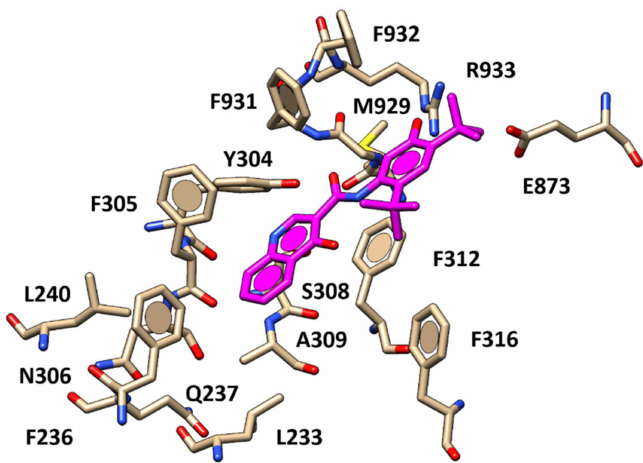
Figure 3. Refined docking positioning of VX-770 ( C atom; magenta) within the human CFTR channel.